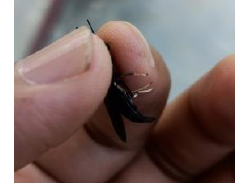
Figure 2: An adult Black soldier waste-bin wall